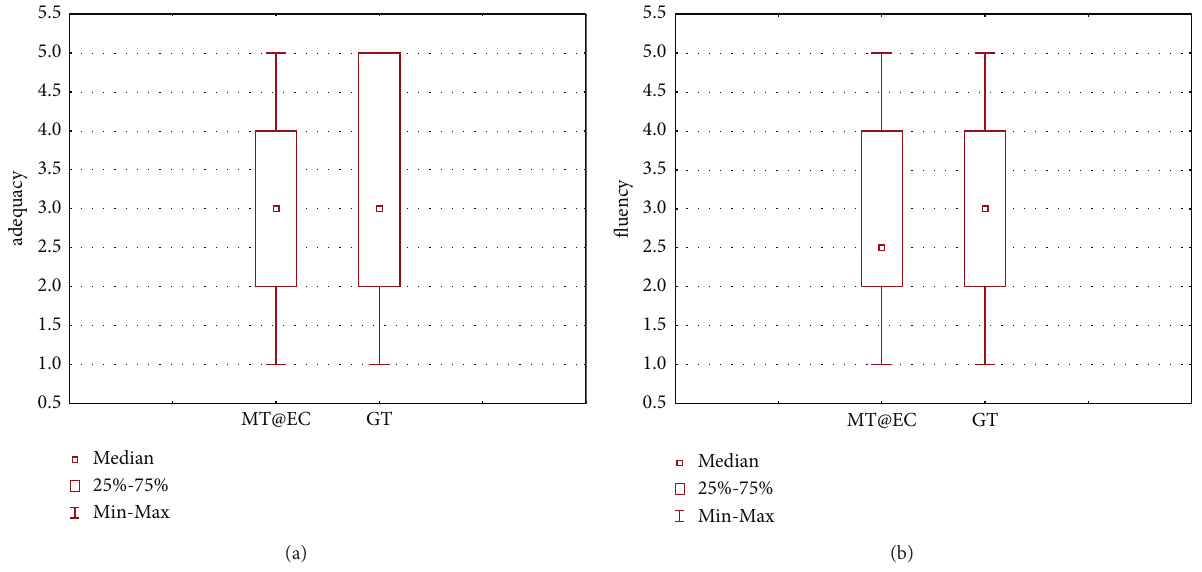
Figure 4: Visualization of descriptive statistics for manual MT evaluation: adequacy (a) and fluency